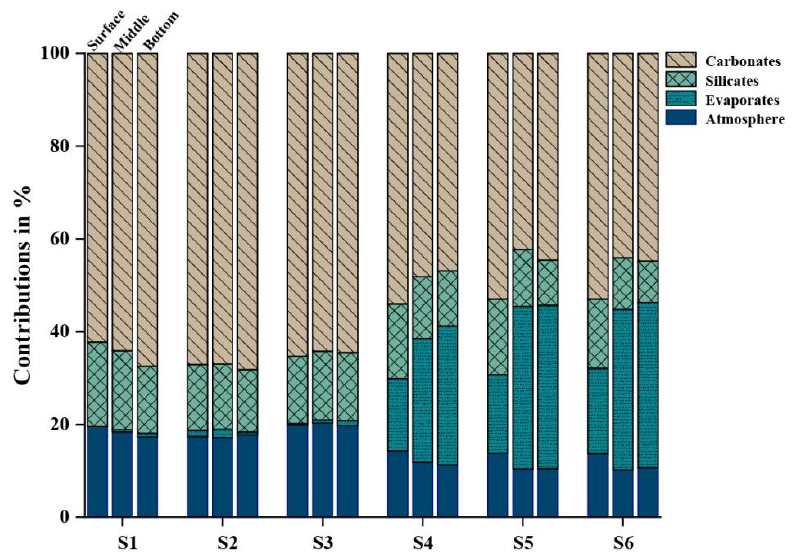
Figure 6. Contribution proportion of ions from different sources to Xiaojiang River.